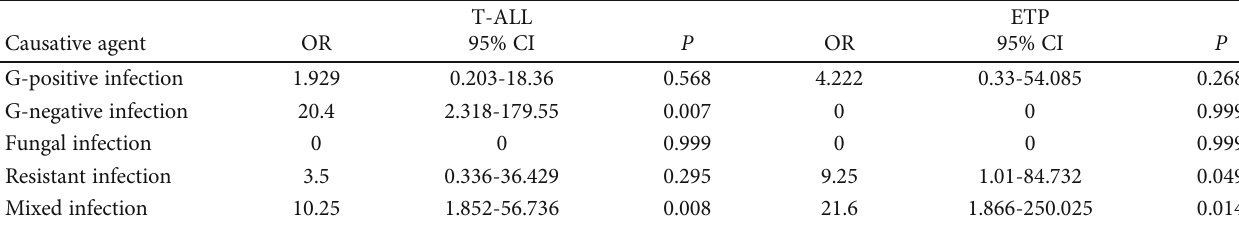
Table 3: Univariate analysis identifying factors associated with IRM.